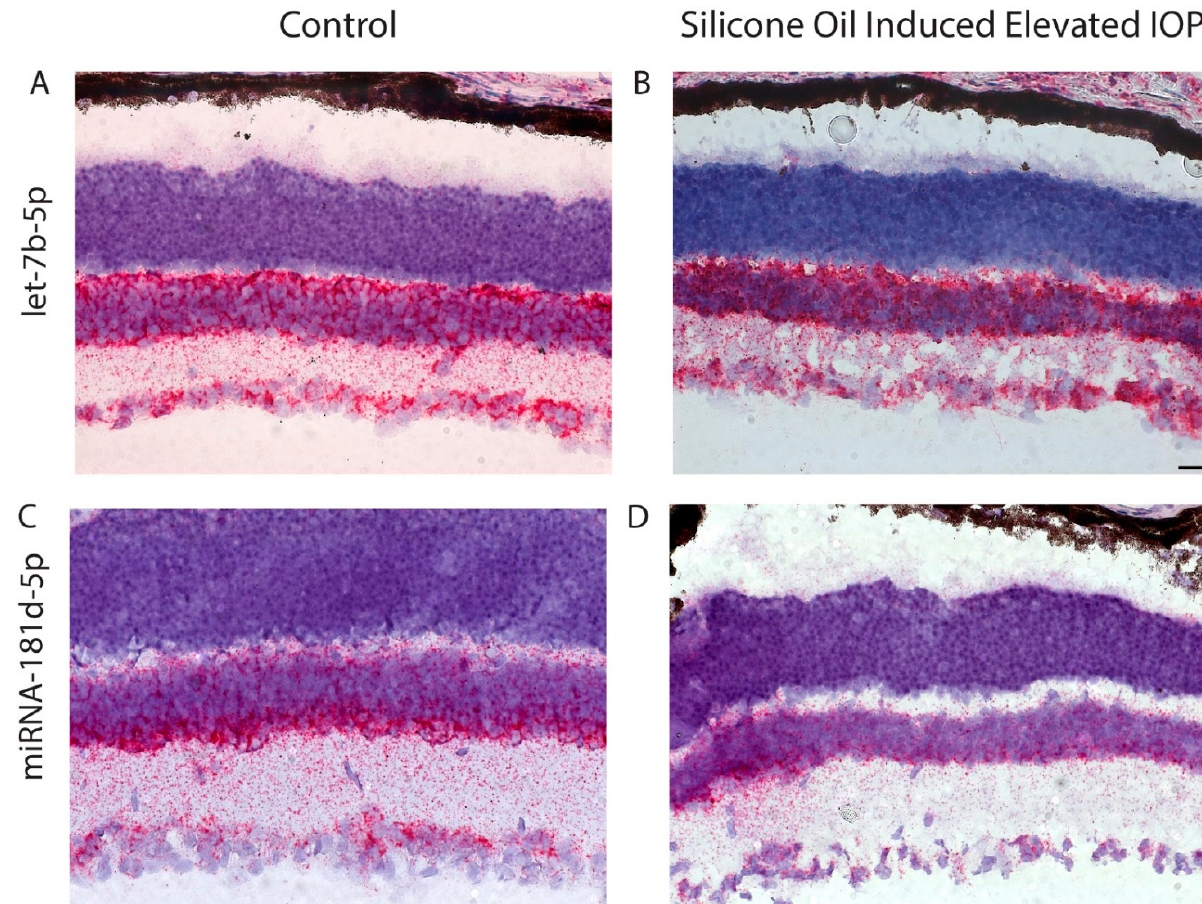
Figure 4. Expression of miRNA in RGC and changes after elevation of IOP. In situ hybridization shows Let-7b-5p expression in the INL and GCL ( A ). No change in signal was detected in Let-7b-5p after elevated IOP ( B ). Expression of miRNA-181d-5p is localized to the INL and GCL ( C ). Following elevation of IOP, the signal of miRNA-181d-5p is appreciably lower in both the GCL and INL ( D ). Scale bar: 10 µm.